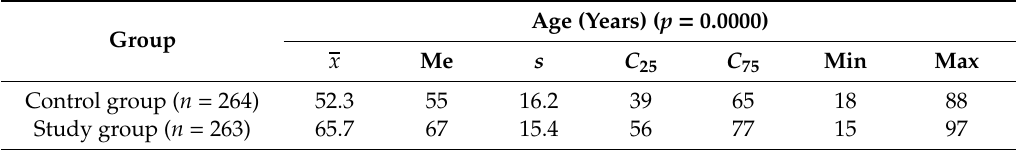
Table 1. Characteristics of the studied and control groups by